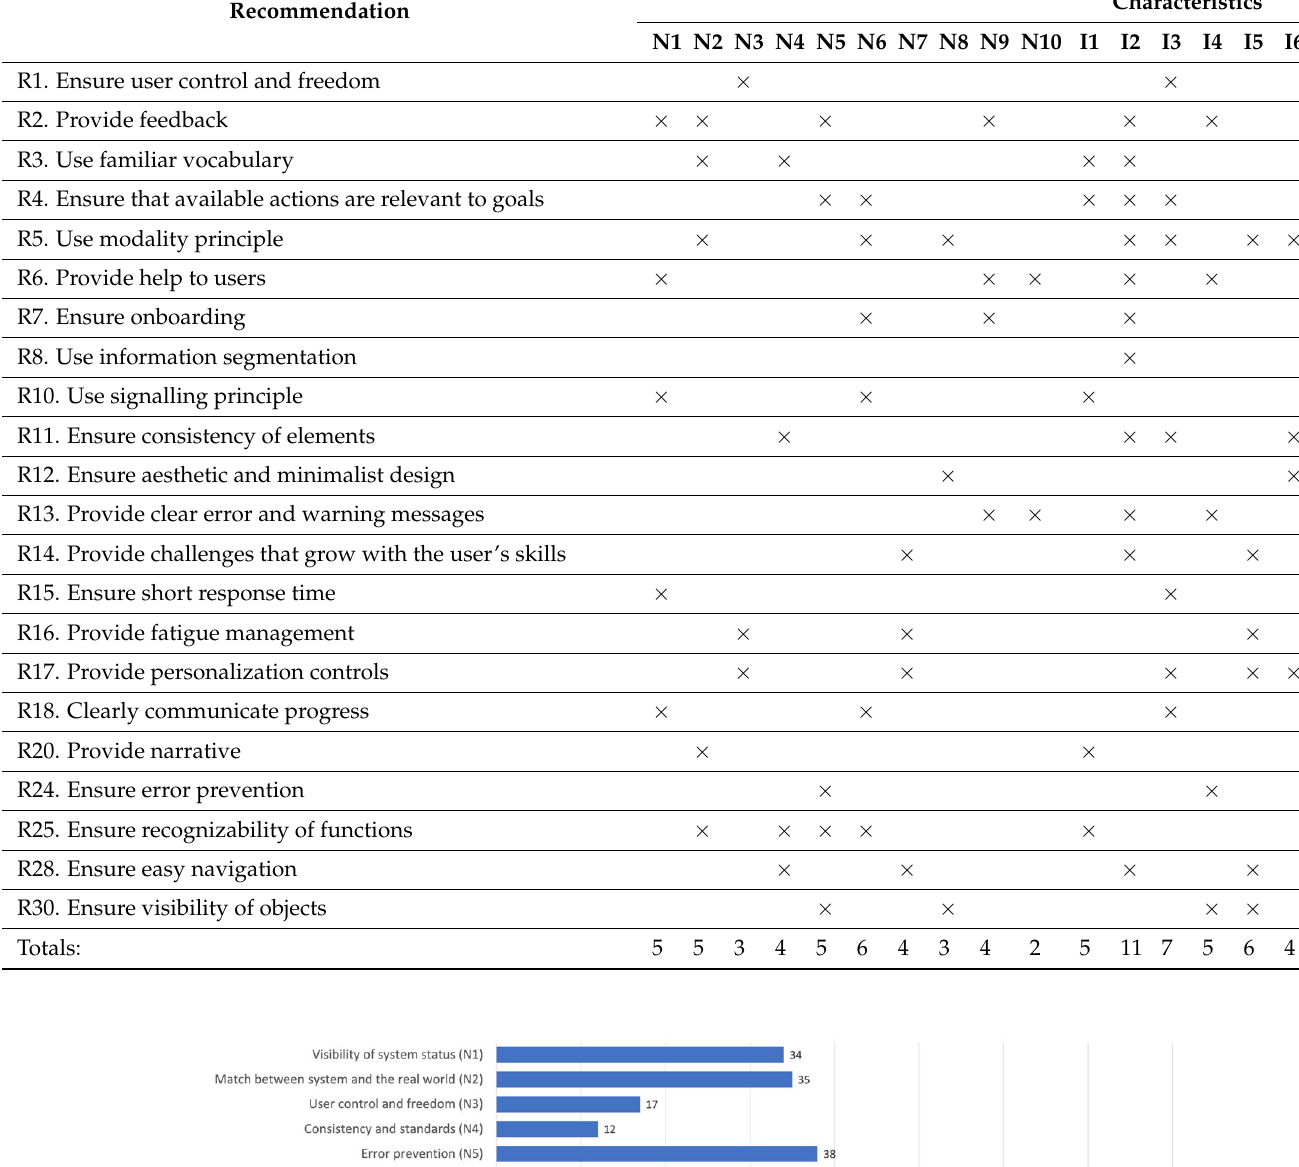
Table 5. Mappings (denoted by × ) between collected generalised recommendations from papers and Nielsen‘s heuristics/ISO 25010 usability characteristics.